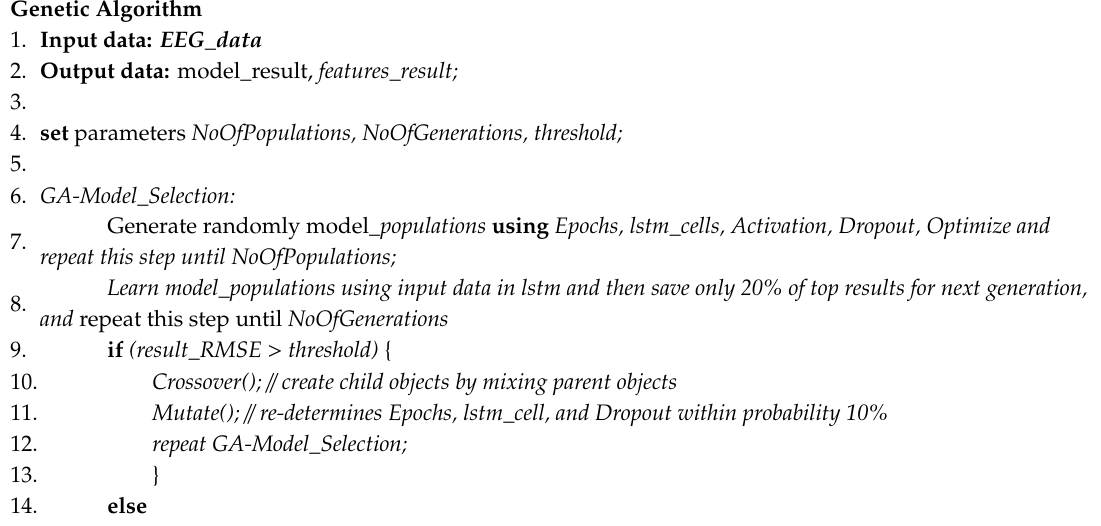
Algorithm 1. The pseudo-code of the genetic algorithm. Genetic